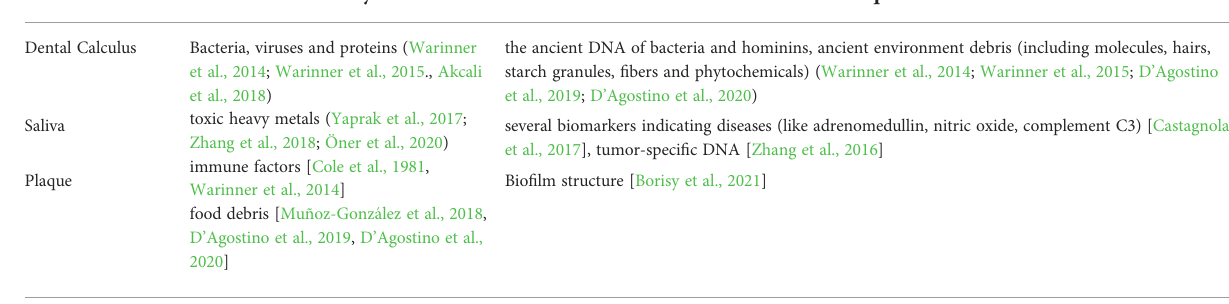
TABLE 1 Comparison of biological components in dental calculus, saliva, and plaque. Owned by all